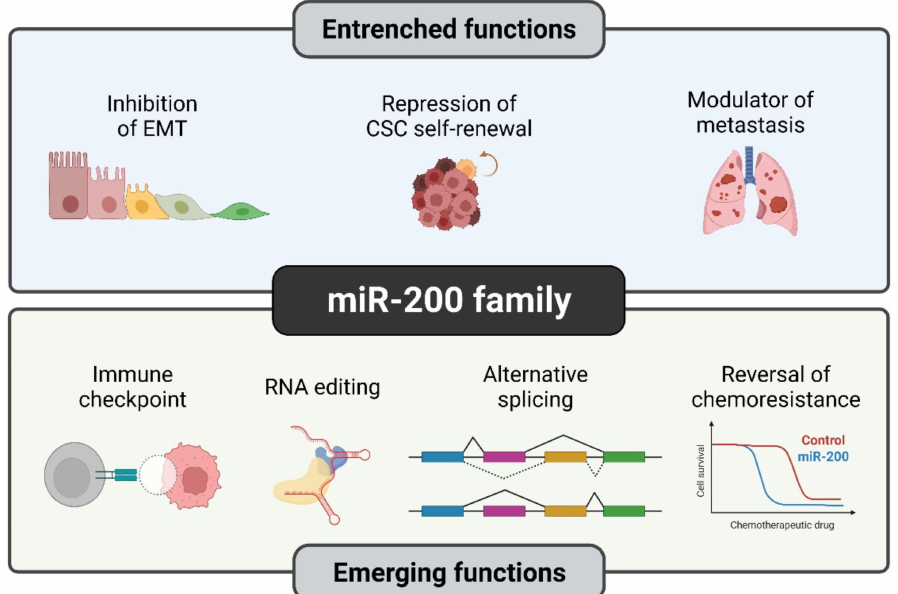
Figure 3. Established and novel functions of the miR-200 family in human cancers. Although certain functions of miR-200s such as EMT suppression are quite well understood, members of the miR-200 family have recently been studied in detail for their novel roles such as RNA editing and reversal of chemoresistance. Illustration created with Biorender.com (https://biorender.com/, accessed on 1 June